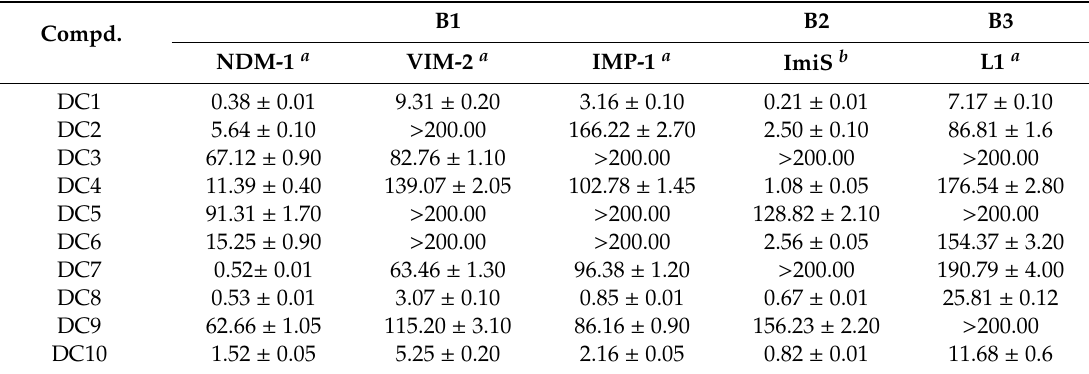
Table 1. IC 50 values of dithiocarbamate derivatives (DC1-10) against M β Ls ( µ M). Compd.